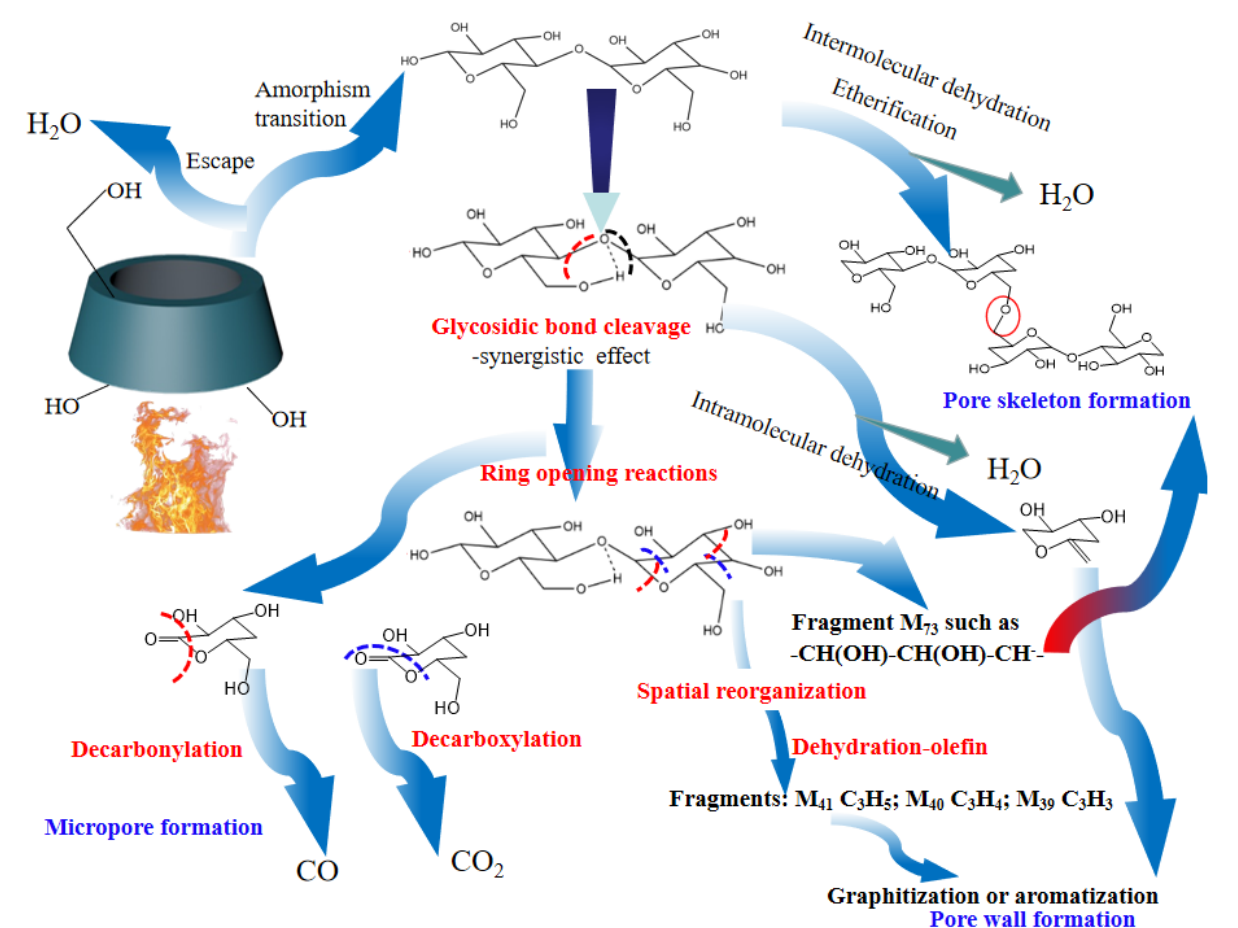
Figure 5. Pore formation mechanism of β -CD during thermal activation.